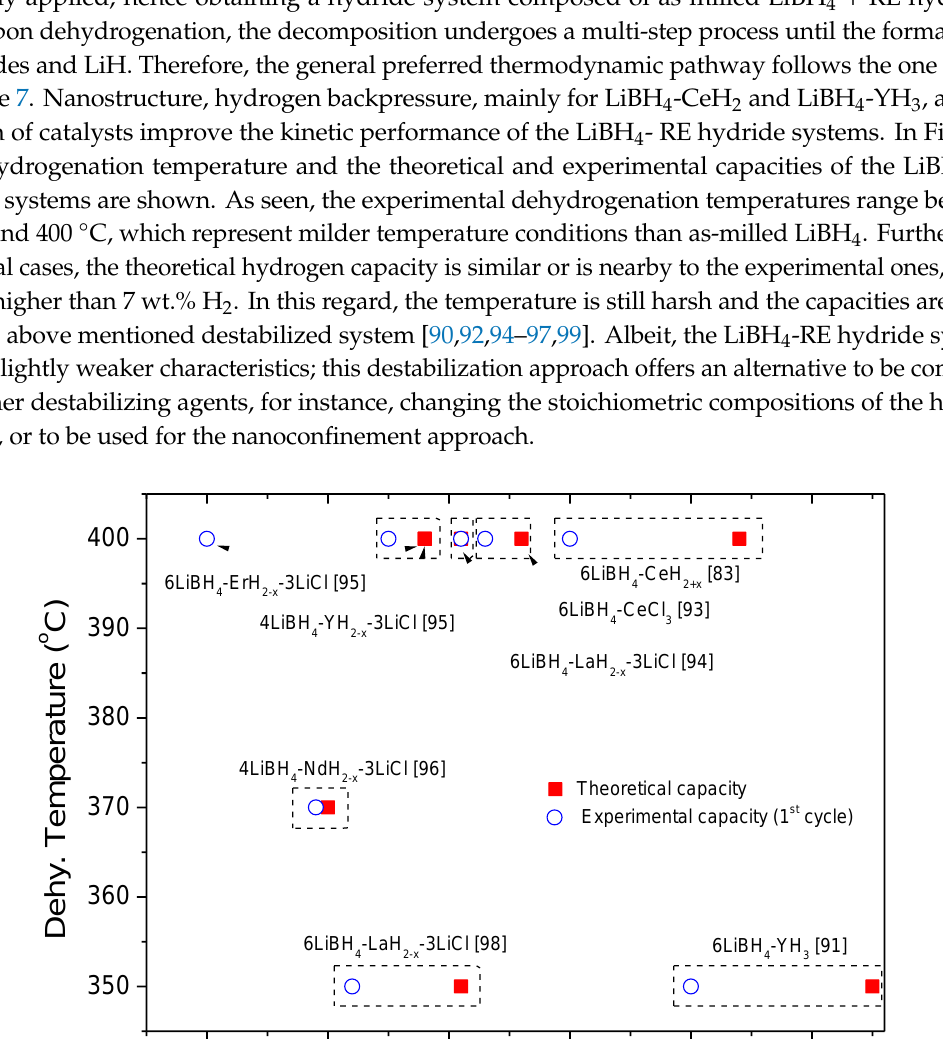
Figure 7. Theoretical and experimental values of hydrogen capacities (wt.%) against the temperature